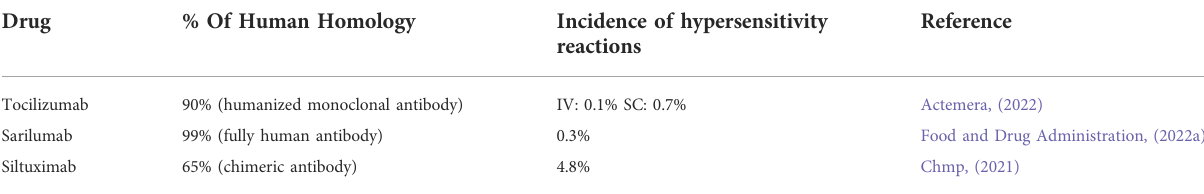
TABLE 2 Incidence of hypersensitivity reactions with the use of different IL-6 inhibitors. Drug % Of Human